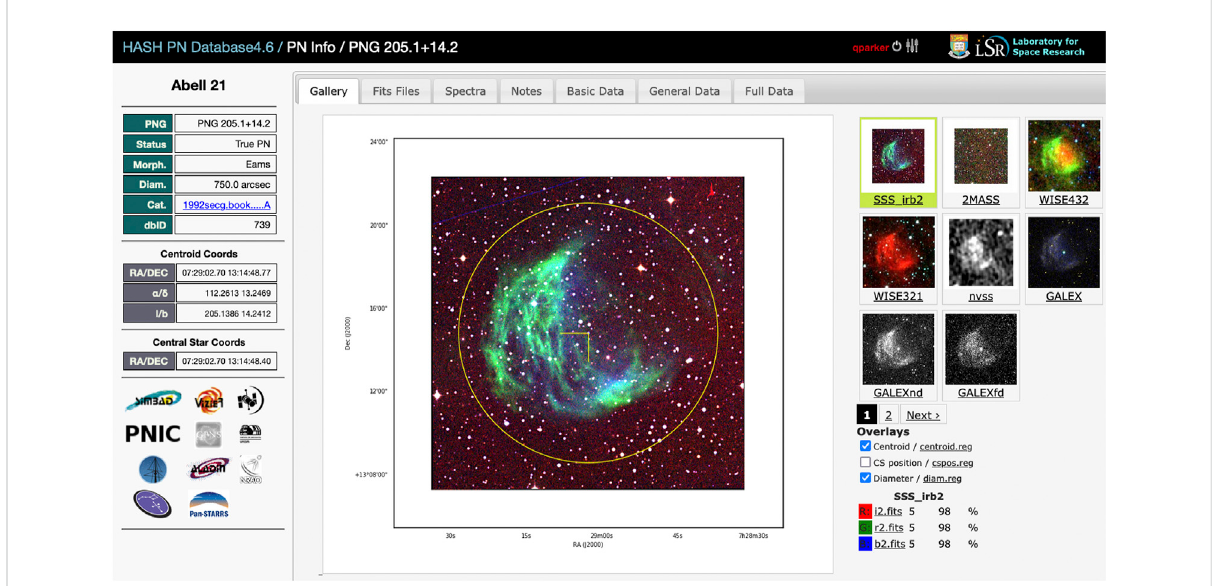
FIGURE 7 HASH image page of PN Abell 21 (HASH ID 739) that well demonstrates the power of multi-wavelength imagery for such a large but prominent PN in the broad-band optical (centre main image). To the right are the principal other multi-wavelength images available. The WISE MIR data shows an inner red region (WISE W4 band) due to the prominence of [OIV] emission at 25.89 μ m, a MIR proxy for the HeII 4686Å optical emission line, showing the PN is of high excitation. The GALEXimageshows the CSPN and the excitation in thesurrounding gas while it is also resolved in